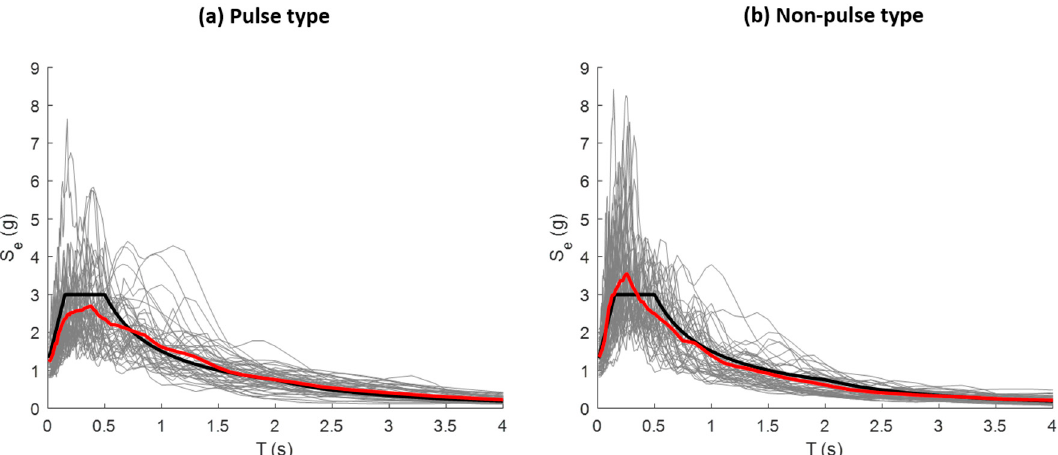
Figure 14. Acceleration response spectra (in grey) of the different recorded ground motions used in the analyses for the ( a ) pulse type and ( b ) non-pulse type records. The target spectrum is shown in black (scaled here to a g = 1.0 g), while the average of the spectra is indicated in red.